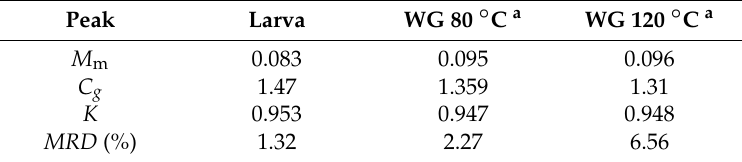
Figure 5. Water uptake as a function of water activity. Experimental data are indicated by filled circles (larva protein), unfilled squares (wheat gluten 80 ◦ C sample) [47] and filled squares (wheat gluten 120 ◦ C sample) [47], and the curves correspond to best fits of Equation (2). Table 4. Guggenheim, Anderson and de Boer (GAB) equation